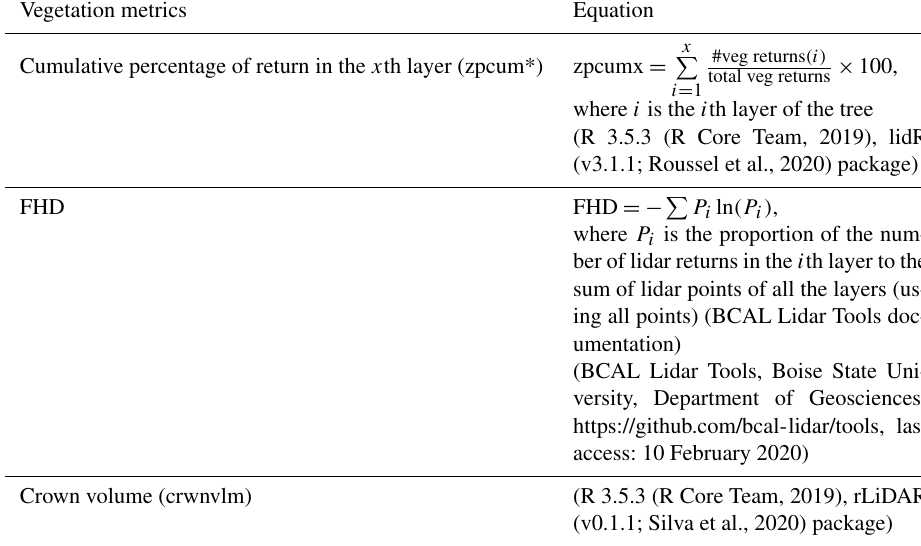
Table A1. Vegetation metrics derived for individual trees at each of the sites with equations and references.